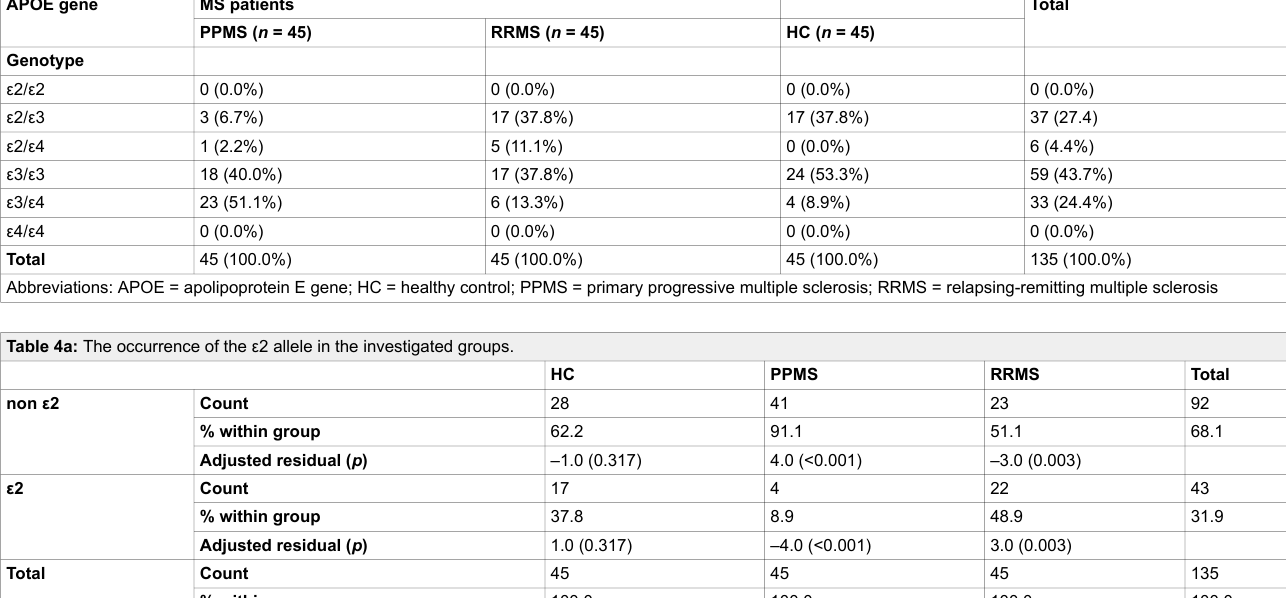
Table 3: Distribution of all APOE genotypes by the investigated groups. MS patientsAPOE gene